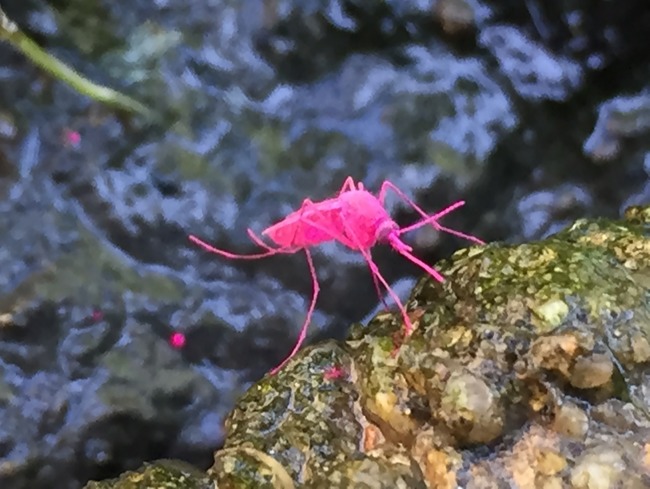
Magenta-marked adult female Culex quinquefasciatus in field conditions Sítio Novo, Olinda, RMR, Brazil, July 22–August 21, 2015.[Photo: Anita Ramesh, LSHTM/IAM/FIOCRUZ].